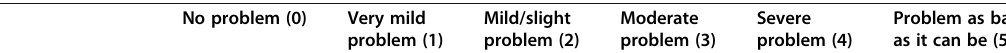
Table 1 English form of